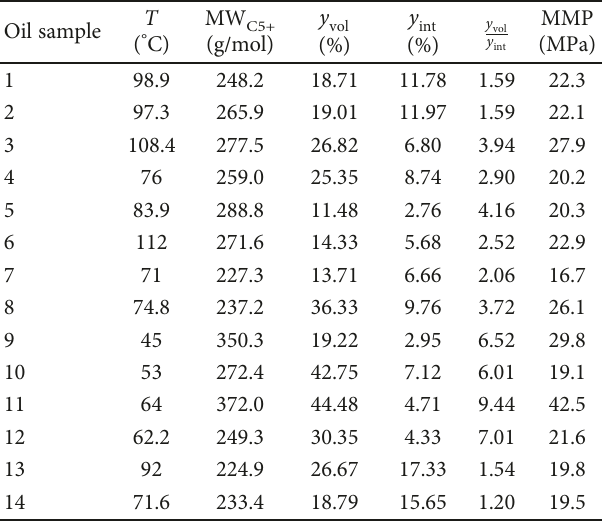
Table 2: Light constituent, oil component, and MMP of China typical reservoirs [19]. Oil